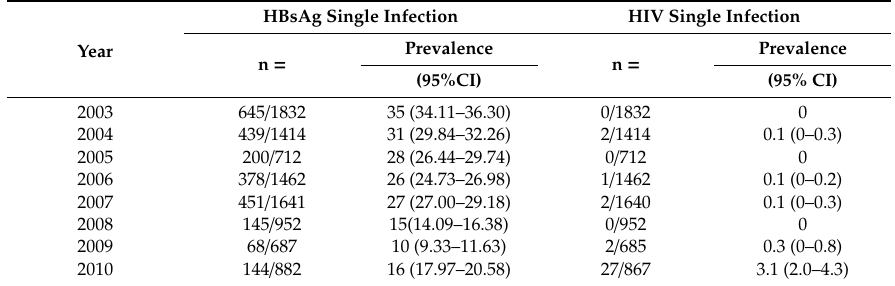
Table A1. The annual prevalence rates of single infection for HBsAg, HIV, Syphilis and HCV in blood donors in East New Britain province from